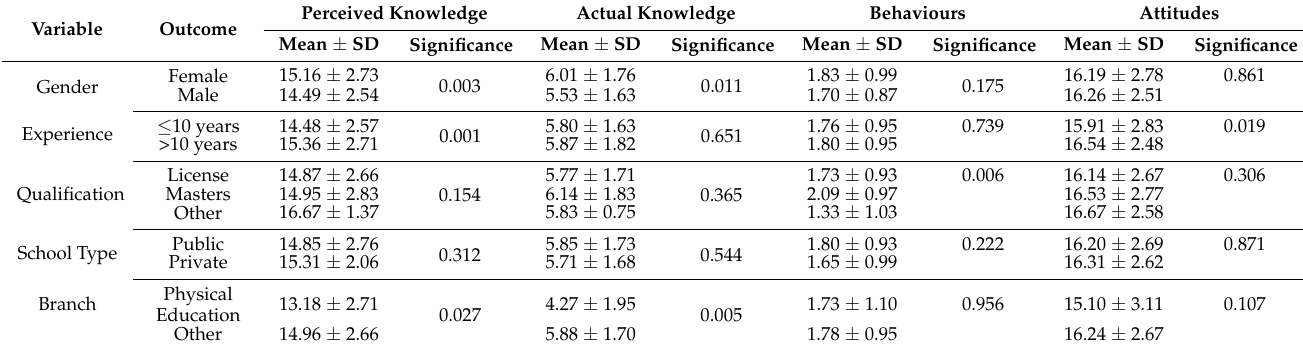
Table 6. Social determinants of elementary schoolteachers’ oral health knowledge, behaviours, and attitudes. Perceived Knowledge Actual Knowledge Behaviours Variable Outcome